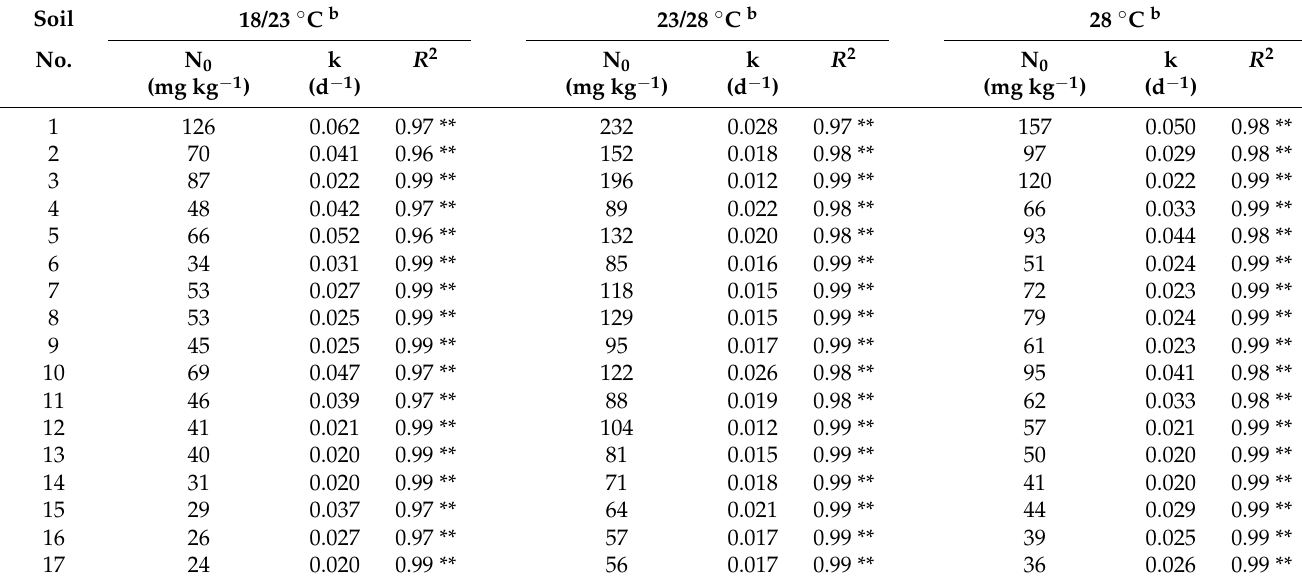
Table 3. Parameters obtained in fitting N mineralization data to a first-order kinetic model after triplicate incubations of 17 soils at three temperature regimes a